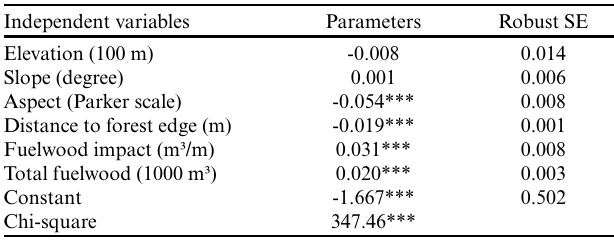
Table 3 . Pooled logit estimation of forest loss.